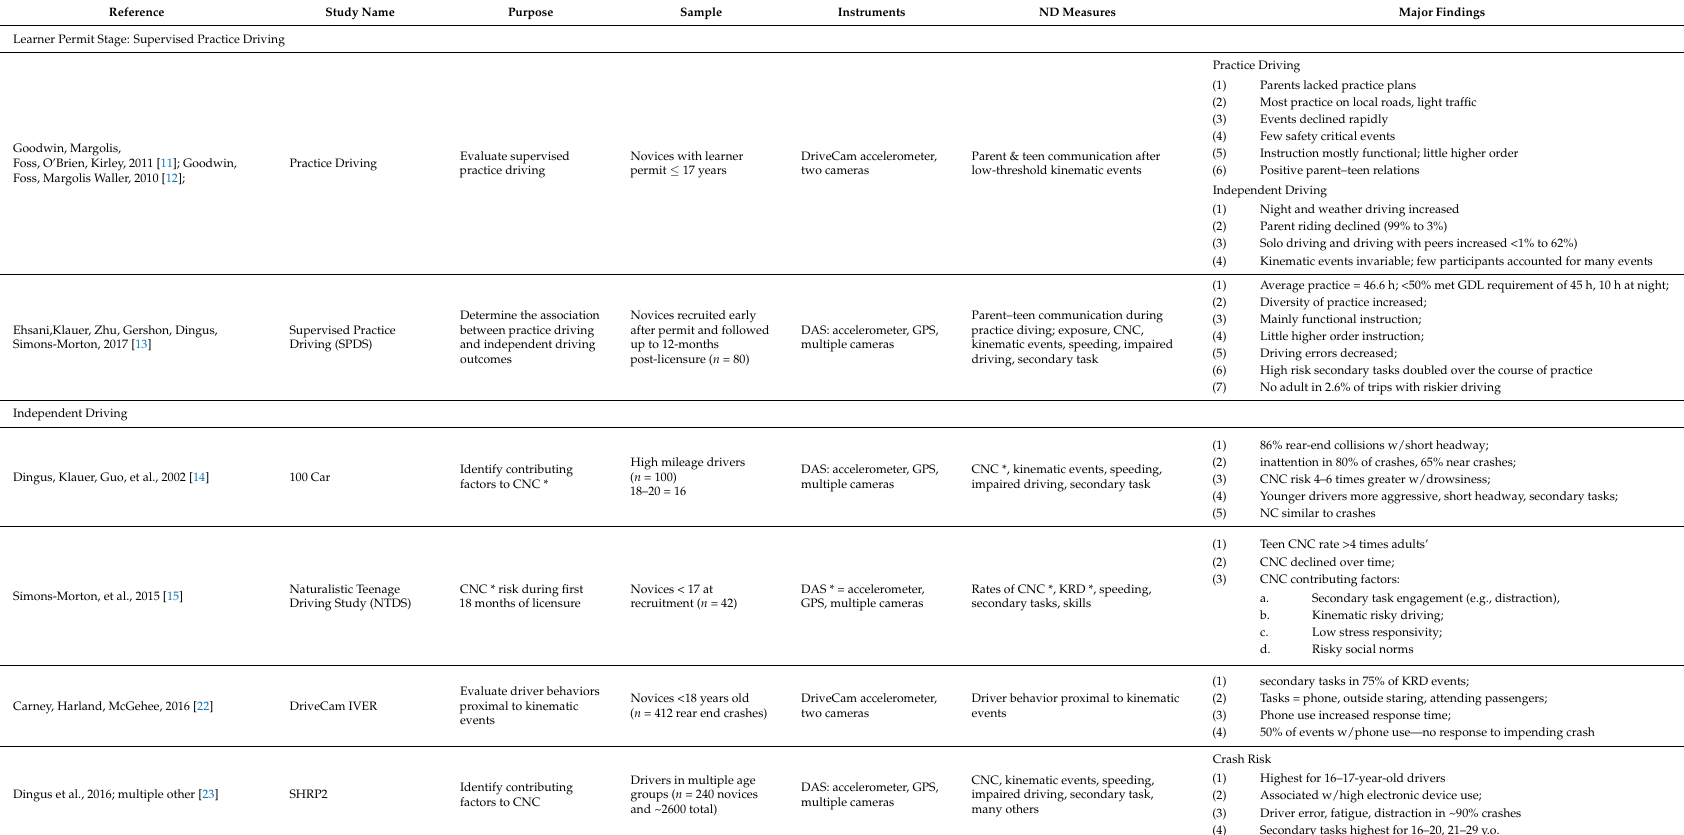
Table 1. Naturalistic driving studies with young driver